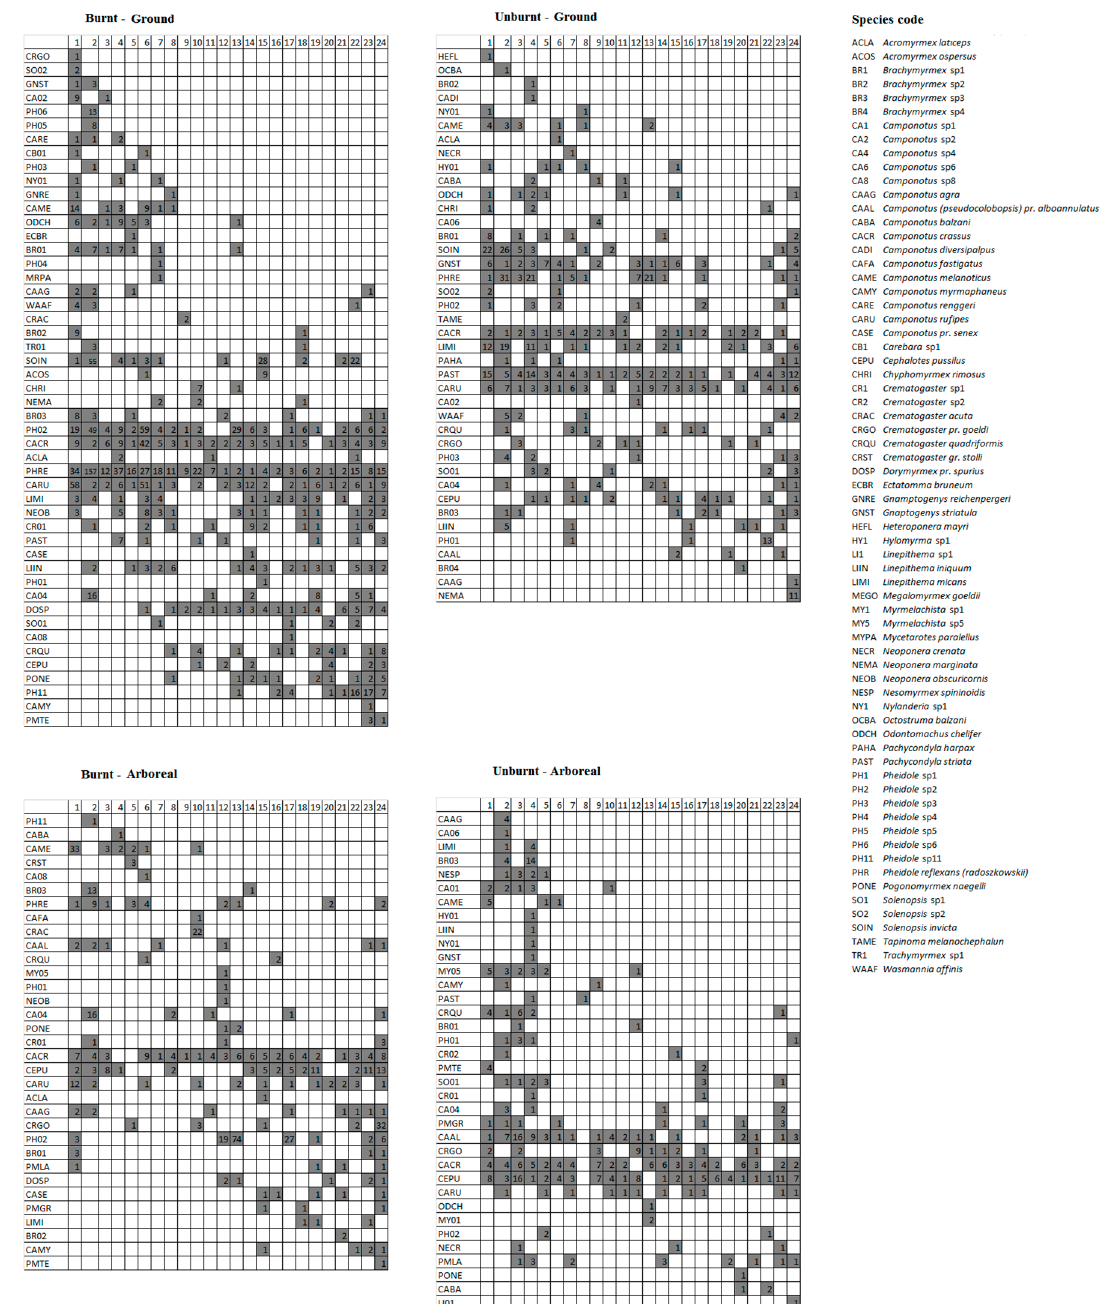
Figure 5. Seriation model of temporal changes in ground and arboreal ant fauna in burnt and unburnt areas. Numbers in the columns represent sample months after fire (1 to 24 months) and rows indicate ant species. Colored cells represent species presence, and the numbers within cells represent the abundance of that species for that month.